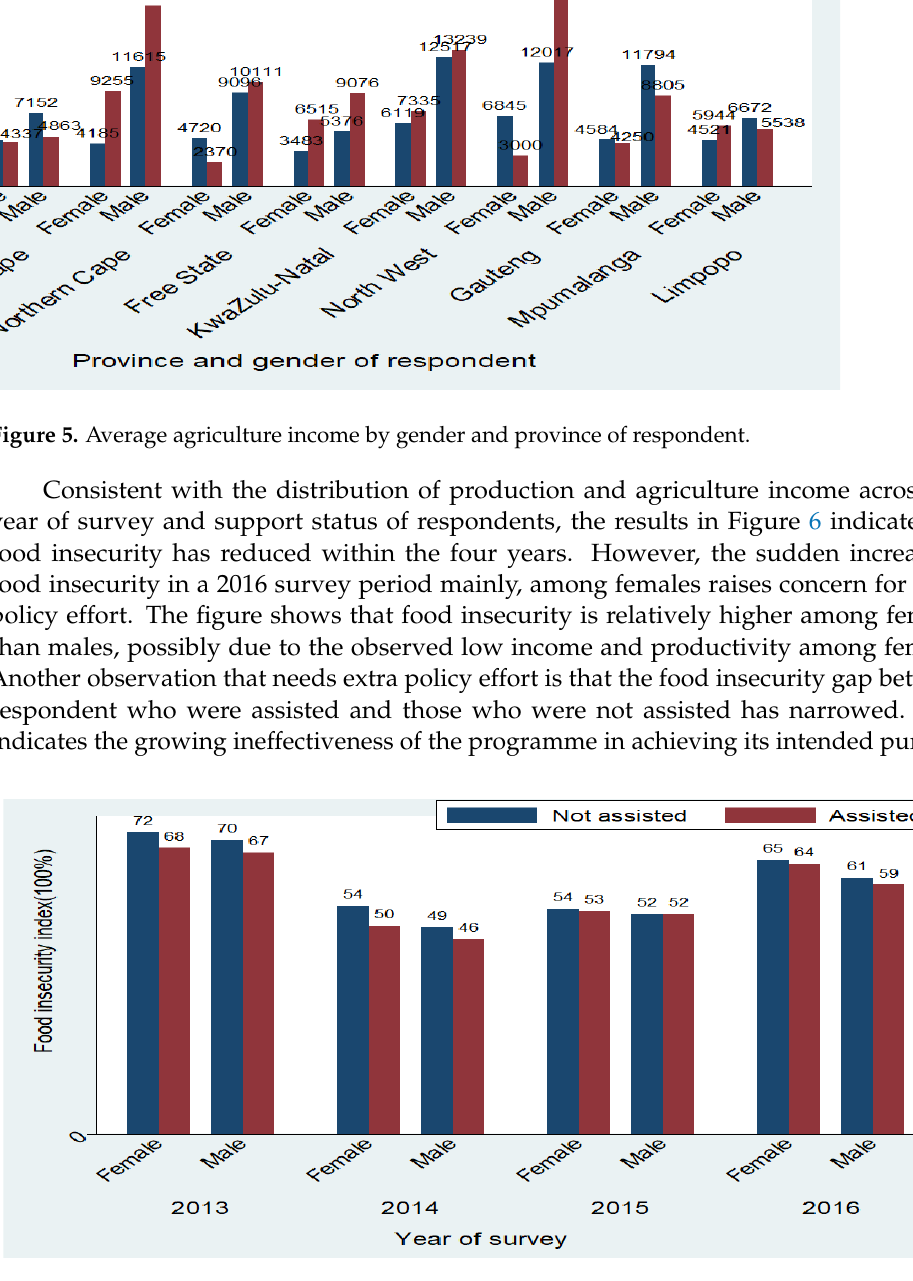
tance. In the Eastern Cape and Northern Cape provinces, food insecurity is unusually higher among both males and females who received the support than those who never received any support. In the Gauteng province, food insecurity is higher among females who received the support than those who did not receive the support. Two factors can explain these and similar observations across production and income. First, respondents had already high level of food insecurity. The second possible reason includes unequal production capacity, unequal access to the support and regional variation in the climatic conditions.